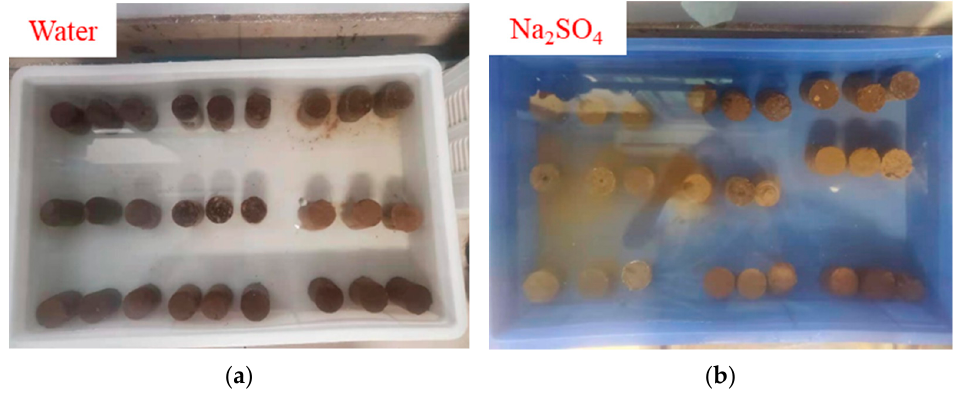
Figure 4. Immersion test. ( a ) Soaked in water, ( b ) Soaked in salt solution.